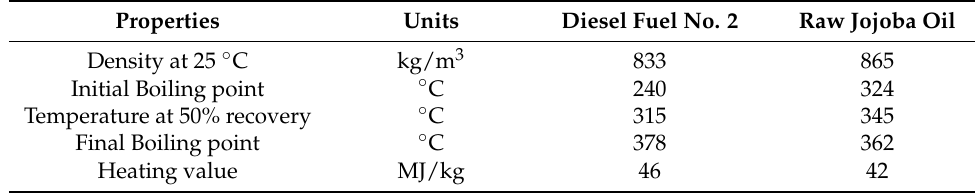
Table 4. Properties of diesel and pure Jojoba oil